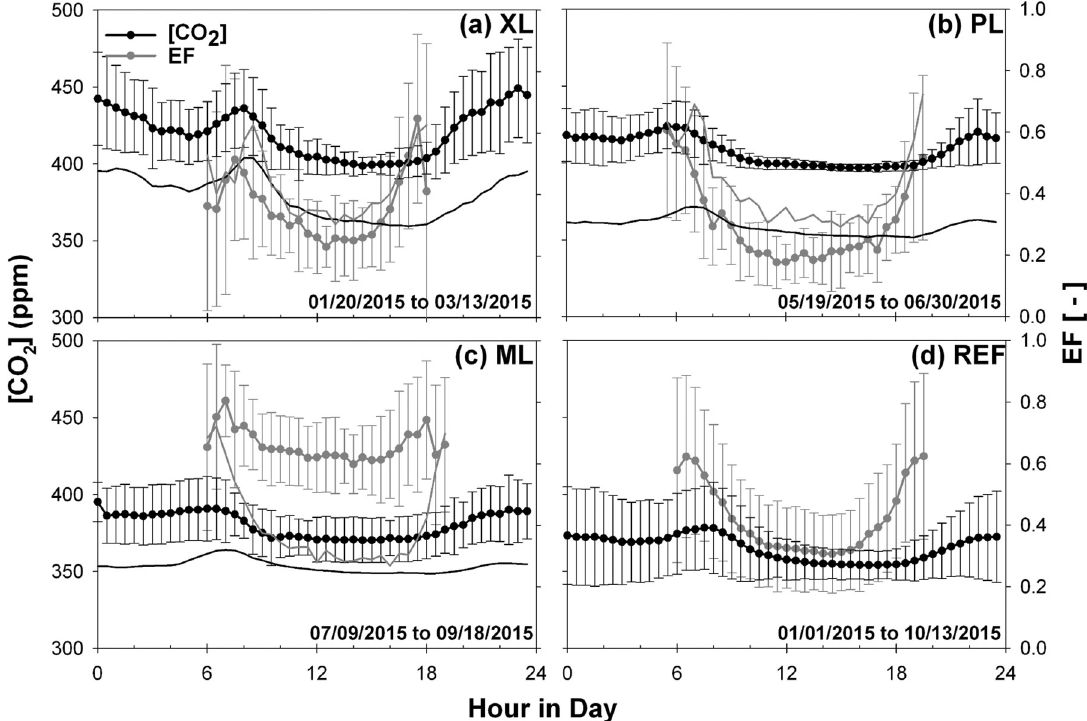
Fig 5. Diurnal averages of [CO 2 ] and EF for the four sites. Average diurnal cycle of CO 2 concentration and evaporative fraction for the (a) XL, (b) PL, (c) ML, and (d) REF sites. Error bars represent one standard deviation over the indicated periods. Thin lines are average diurnal cycles at the REF site during the same period as the mobile deployment for [CO 2 ] (black) and EF (gray). Different sampling periods are specified in each plot.